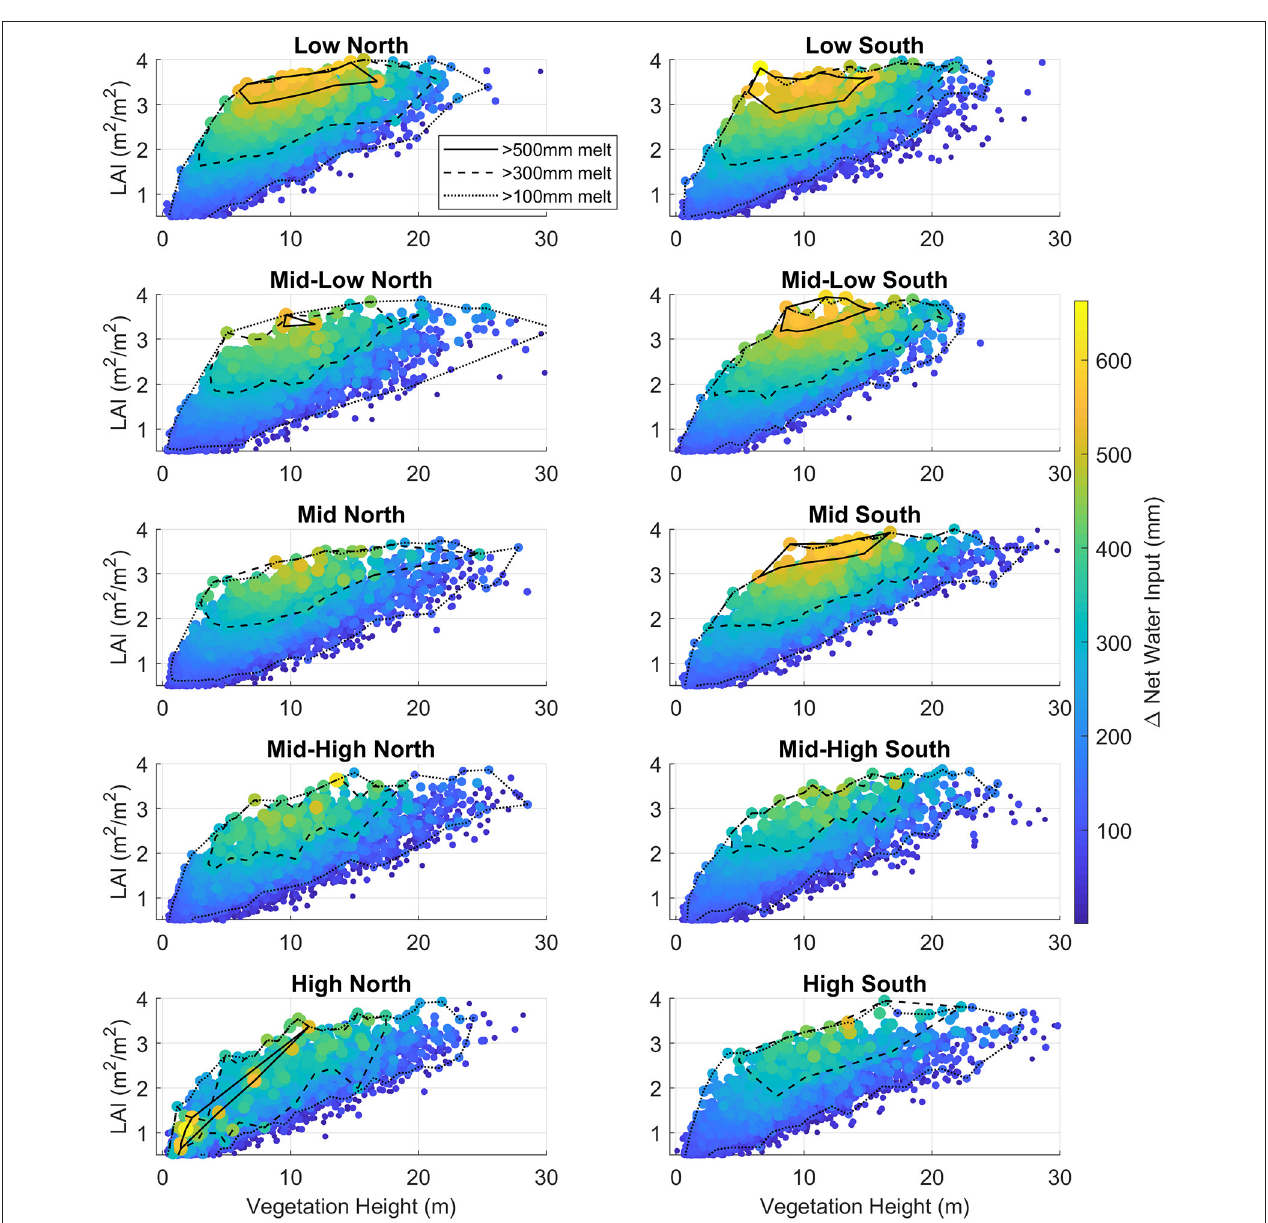
FIGURE 6 | Forest patch (30m) increase in total net water input across Snow Zones for both thinning scenarios and organized by existing vegetation LAI and height. Dots are colored and sized according to changes to net water input. Continuous, dashed and pointed lines show the boundary of points with changes in melt volume > 500, 300, and 100mm,